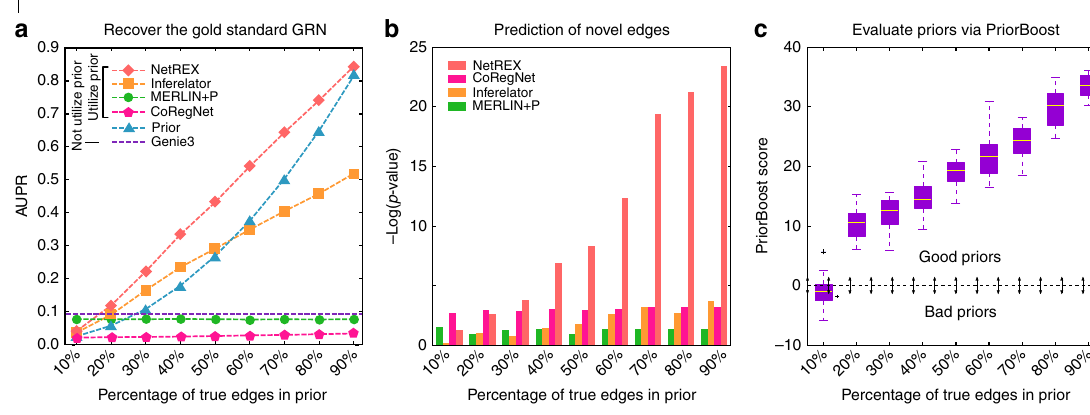
Comparison on various of ratio of true to false edges in prior networks with 50% “golden standard”